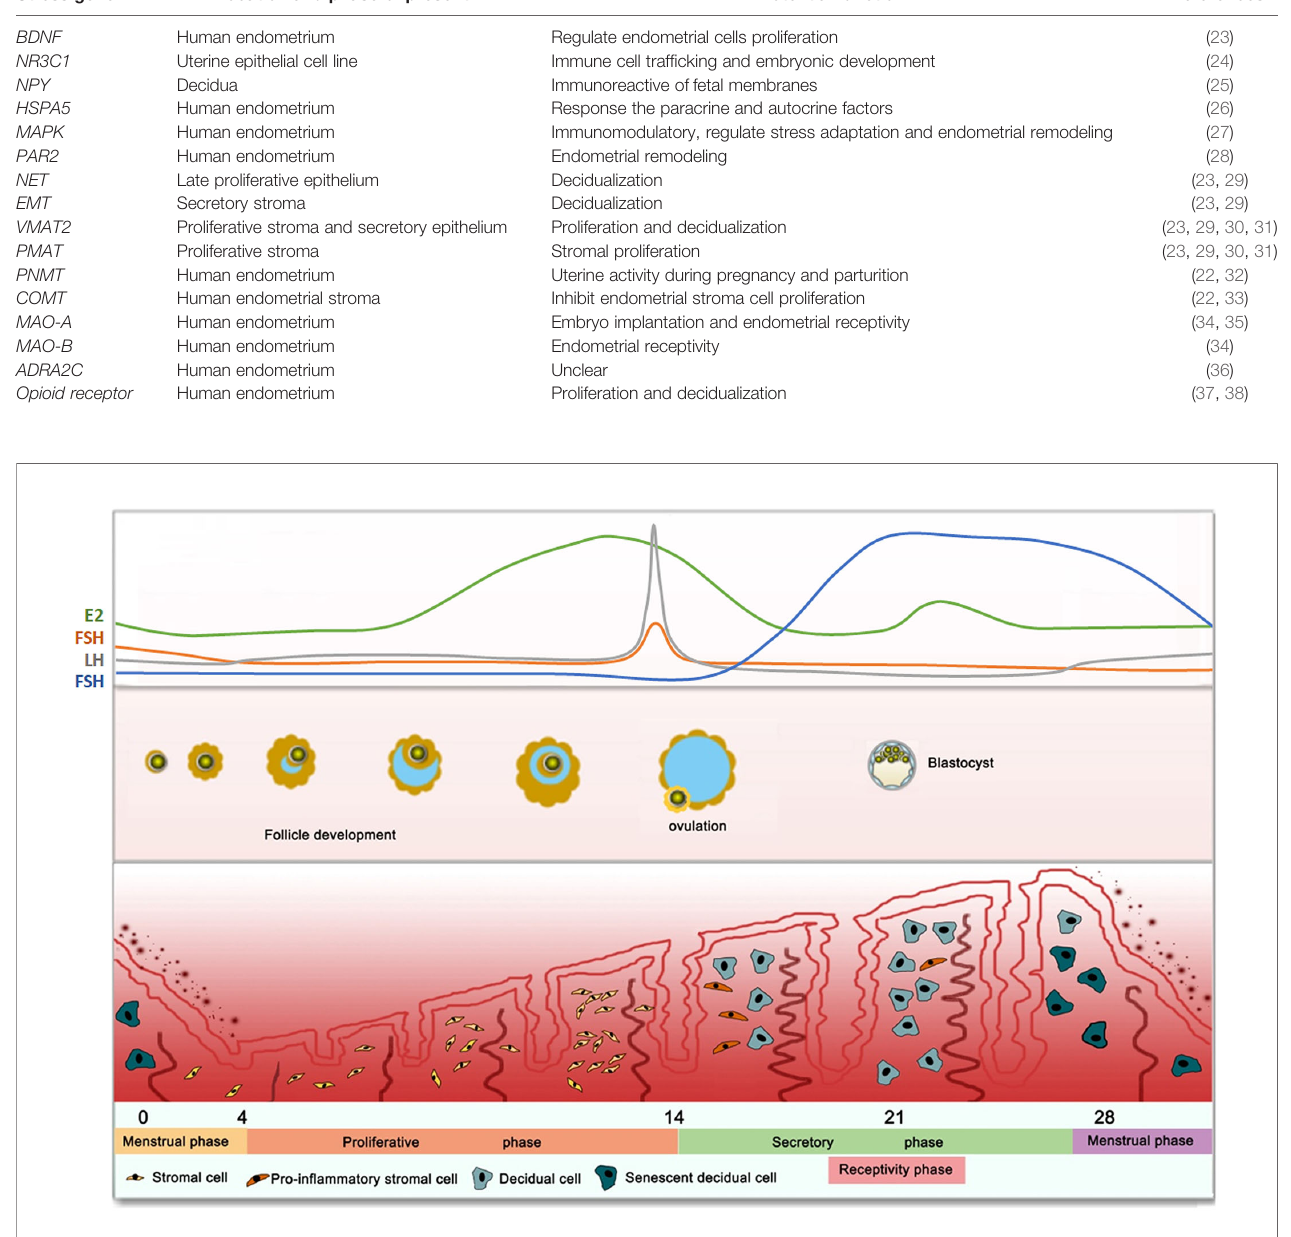
FIGURE 1 | Dynamic Changes of Human Endometrium in Response to Hormones.